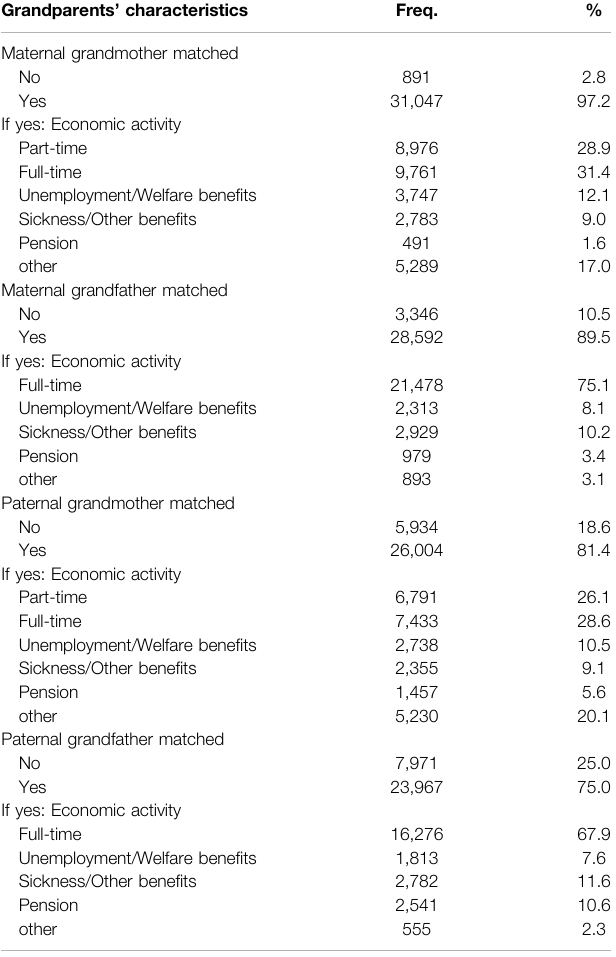
TABLE 3 | Summary statistics ofkey variables of grandparents of young mothers ’ fi rst child. Grandparents ’ characteristics Freq.